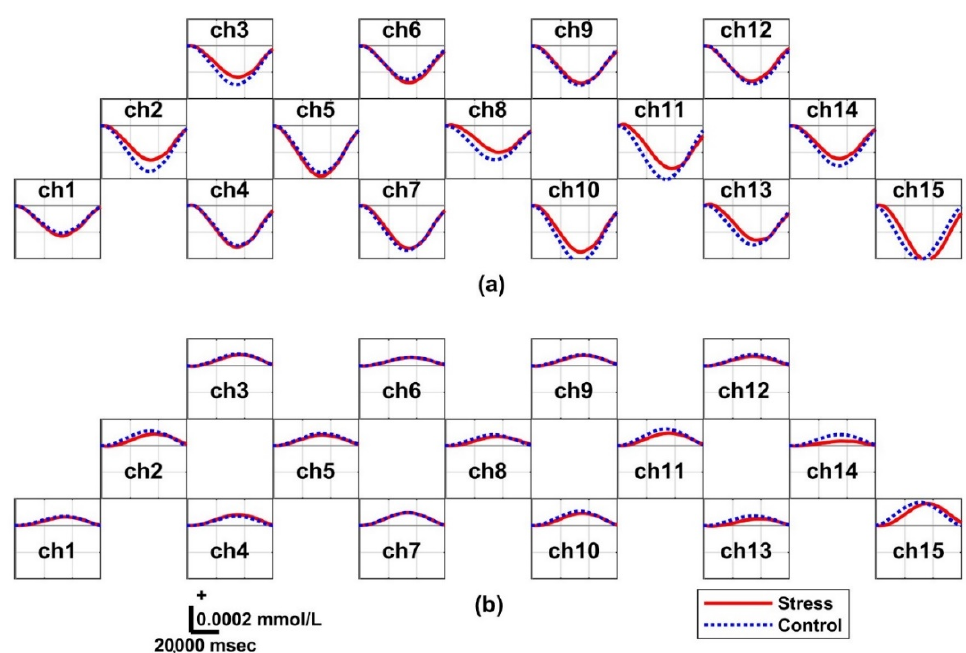
Figure 4. Grand averaged temporal hemodynamic oscillation changes within the interval of each epoch in Session 1 for the control and stress groups: ( a ) oxygenated hemoglobin ( ∆ HbO) and ( b ) reduced hemoglobin ( ∆ HbR). The red and blue dotted lines correspond to the stress and control group, respectively. The control group shows slightly higher average brain activation than the stress group under Session 1 of finding positive stimulation conditions.